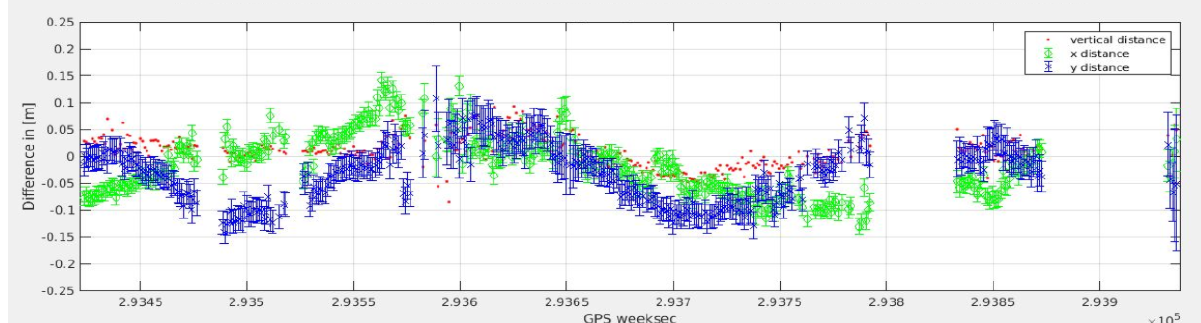
Figure 10. Absolute coordinate differences between high-grade GNSS (mode A) and aerial image derived position on 14 th July 2021. Error bars showing the intrinsic standard deviation of the high-grade GNSS trajectory.